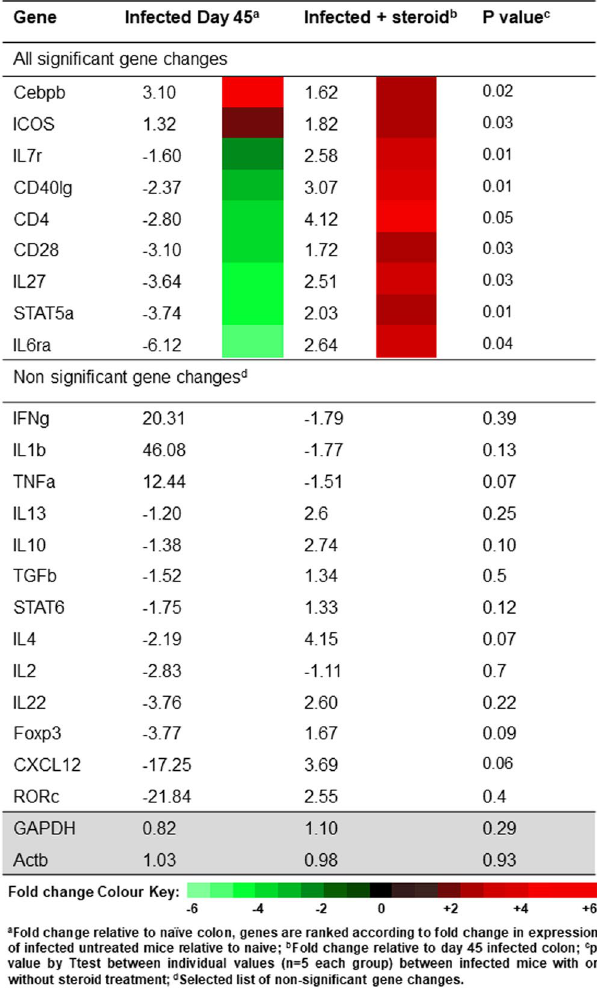
Figure 4. Altered regulation of key genes between T . muris -infected and steroid treated groups. Fold change in the colonic expression of adaptive immune response genes between day 45 steroid treated versus untreated T . muris- infected mice, and T . muris infected mice after hydrocortisone treatment. Fold changes are ranked according to fold change in expression of infected untreated mice relative to